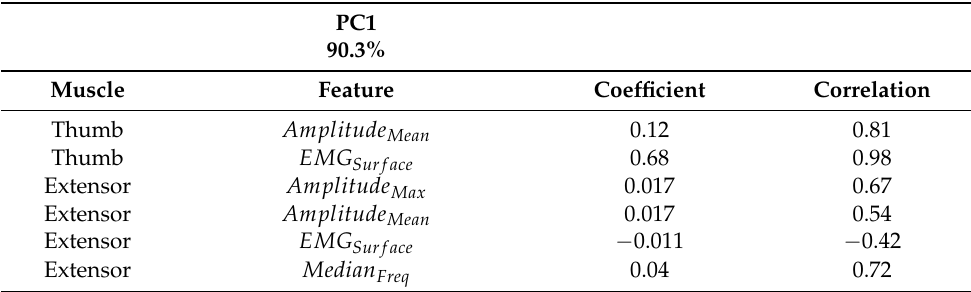
Table 8. PC coefficients and correlations between features and corresponding PC for the fifth scenario. Only | r | > 0.4 are